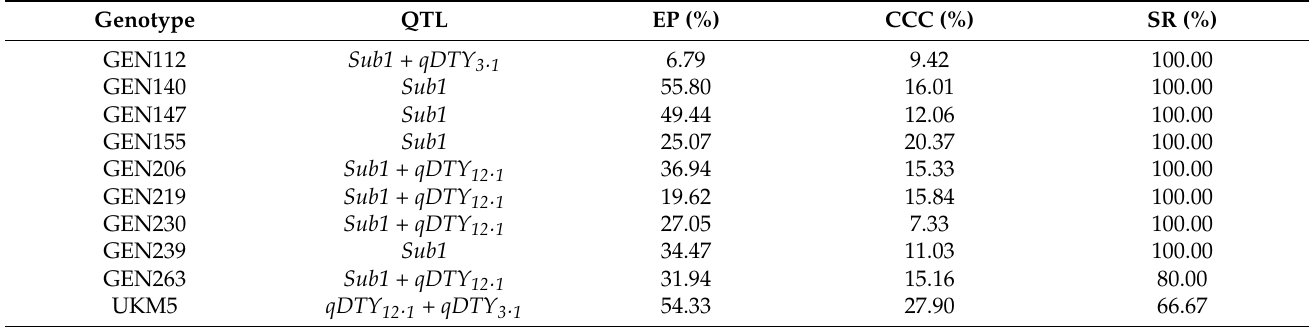
Table 5. Selected lines and the mean of elongation percentage (EP), percentage of change of chlorophyll content (CCC) and survival rate (SR) in vegetative stage submergence stress (VS) trial. Genotype